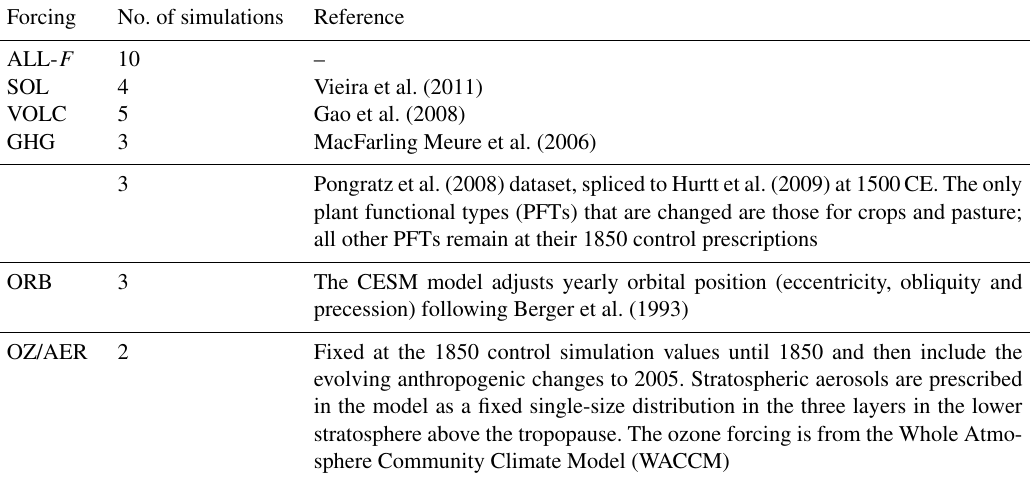
Fixed at the 1850 control simulation values until 1850 and then include the